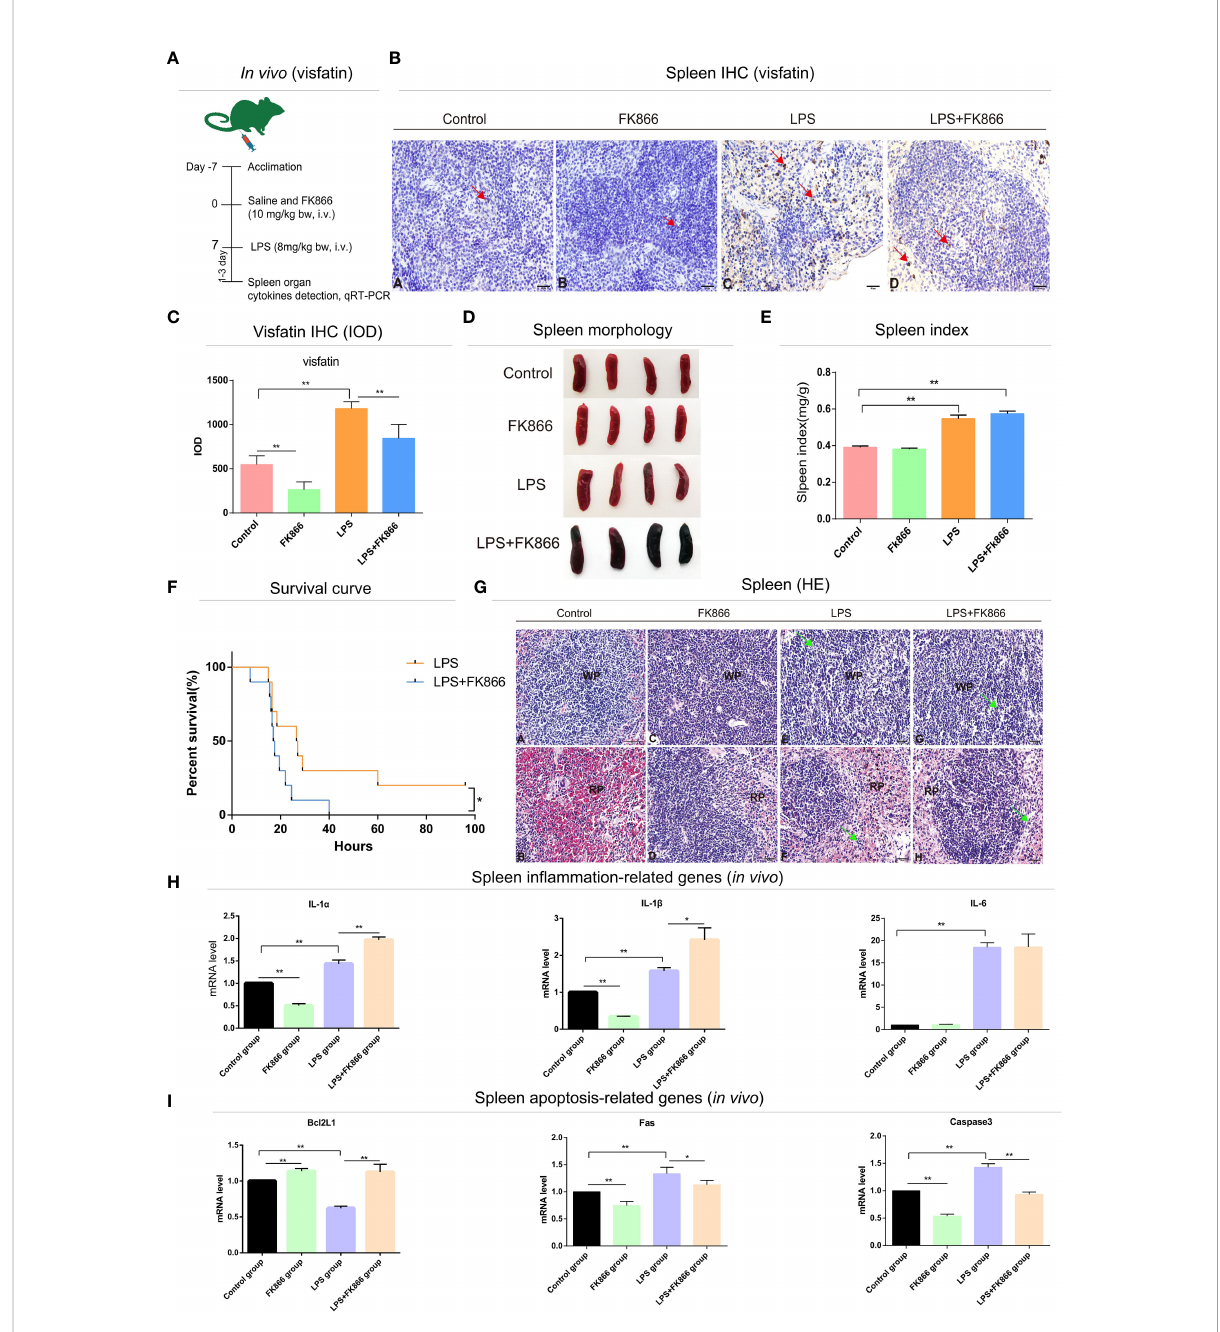
FIGURE 3 Effects of endogenous visfatin on in fl ammation and apoptosis in mice spleen. (A) Experimental timeline of the exogenous FK866 (10 mg/kg bw, i.v.) and LPS (8 mg/kg bw, i.v.) treatment in mice ( n =10 per group, in vivo ). (B) IHC detection of visfatin expression in mice spleen from different treatment groups, Yellowish brown reaction product refers to visfatin-positive signal distribution, marked by red arrow. (C) Detection of the IOD value and counting of the expression of visfatin in mice spleen from different treatment groups (** P <0.01). (D) Gross lesions of the mice spleen in different treatment groups. (E) Spleen index of different treatment groups (** P <0.01). (F) Survival rates of different treatment groups (* P <0.05). The test was divided into two groups, the FK866 group received single-dose injections of FK866 (10 mg/kg bw, i.v.) for 7 consecutive days, while the LPS+FK866 group received single doses of FK866 (10 mg/kg bw, i.v.) for 7 consecutive days following a single lethal dose of LPS (20 mg/kg bw, i.v.). Statistics of survival of mice in each group ( n =10 per group). (G) Histological analysis mice spleen in different treatment groups. WP, white pulp; RP, red pulp; Green arrows point to apoptotic bodies. Spleen WP (A) and RP (B) in control group; spleen WP (C) and RP (D) in FK866 group; spleen WP (E) and RP (F) in LPS group; spleen WP (G) and RP (H) in LPS+FK866 group. (H) qRT-PCR detection of the mRNA expression levels in in fl ammation-related cytokines of the mice spleen in different treatment groups (* P <0.05, and ** P <0.01). (I) qRT-PCR detection of the mRNA expression levels in apoptosis-related cytokines of the mice spleen in different treatment groups (* P <0.05, and ** P